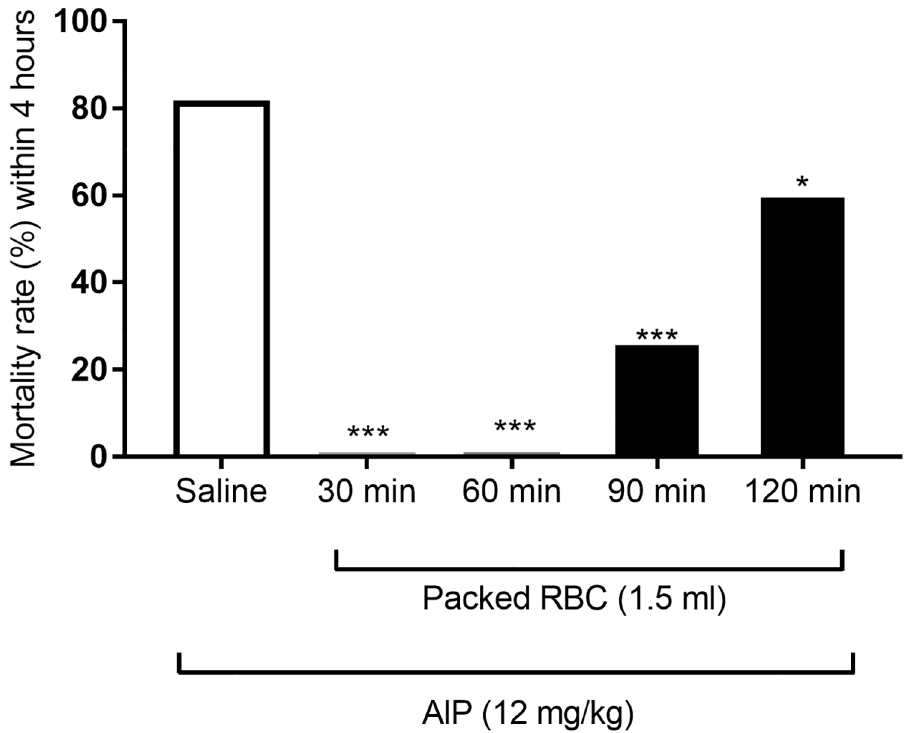
Fig 2. Effects of transfusions of fresh packed red blood cells (RBC) on mortality rate of aluminum phosphide (AlP)-poisoned rats. Packed RBC (1.5 ml) was infused 30, 60, 90 and 120 min after oral administration of AlP (12 mg/ kg) and the mortality rate was assessed within 4 hours. (cid:3) P < 0.05, (cid:3)(cid:3)(cid:3)(cid:3) P < 0.001 compared to saline-treated